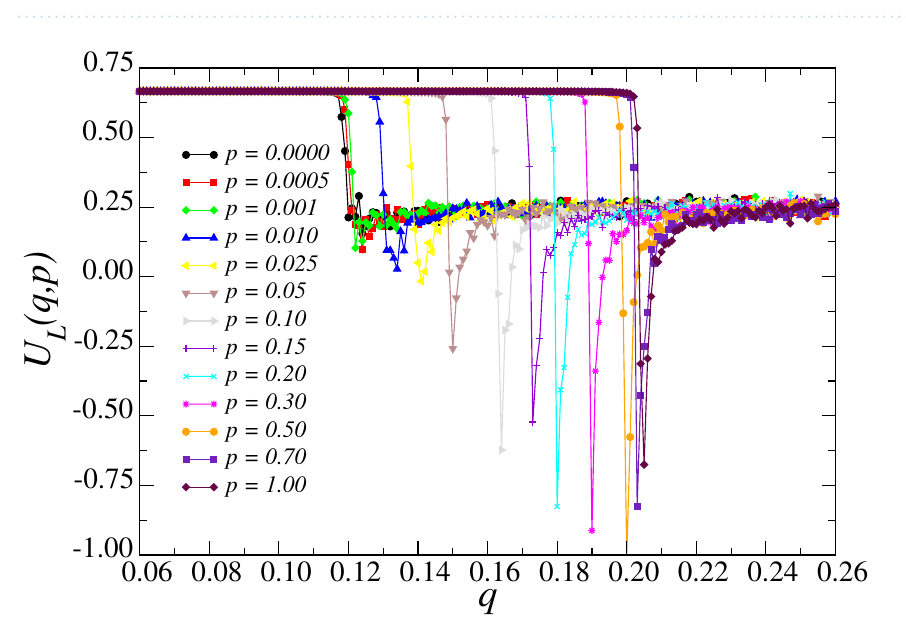
Figure 7. Binder fourth-order cumulant’s U L ( q , p ) dependence on the noise parameter q for several values of the rewiring probability p and L = 140 . U L ( q , p ) moves to the right as the rewiring probability p increases, in agreement with M L ( q , p ) and χ L ( q , p ) . The error bars are smaller than the symbol size, and the lines are just a guide to the